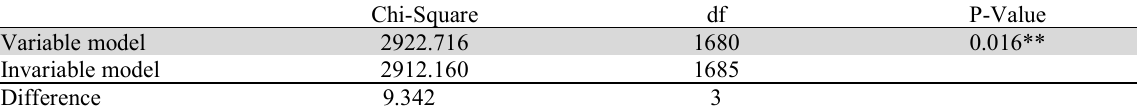
The results of the Chi-Square test